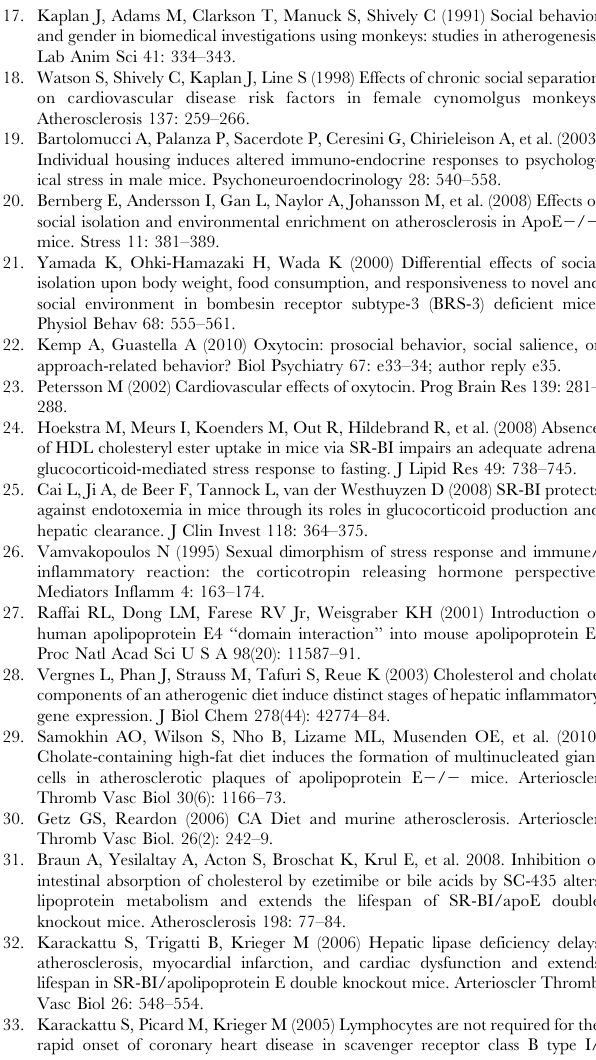
Figure S2 Effects of population density on apparent daily food intake of Paigen diet-fed HypoE male mice.